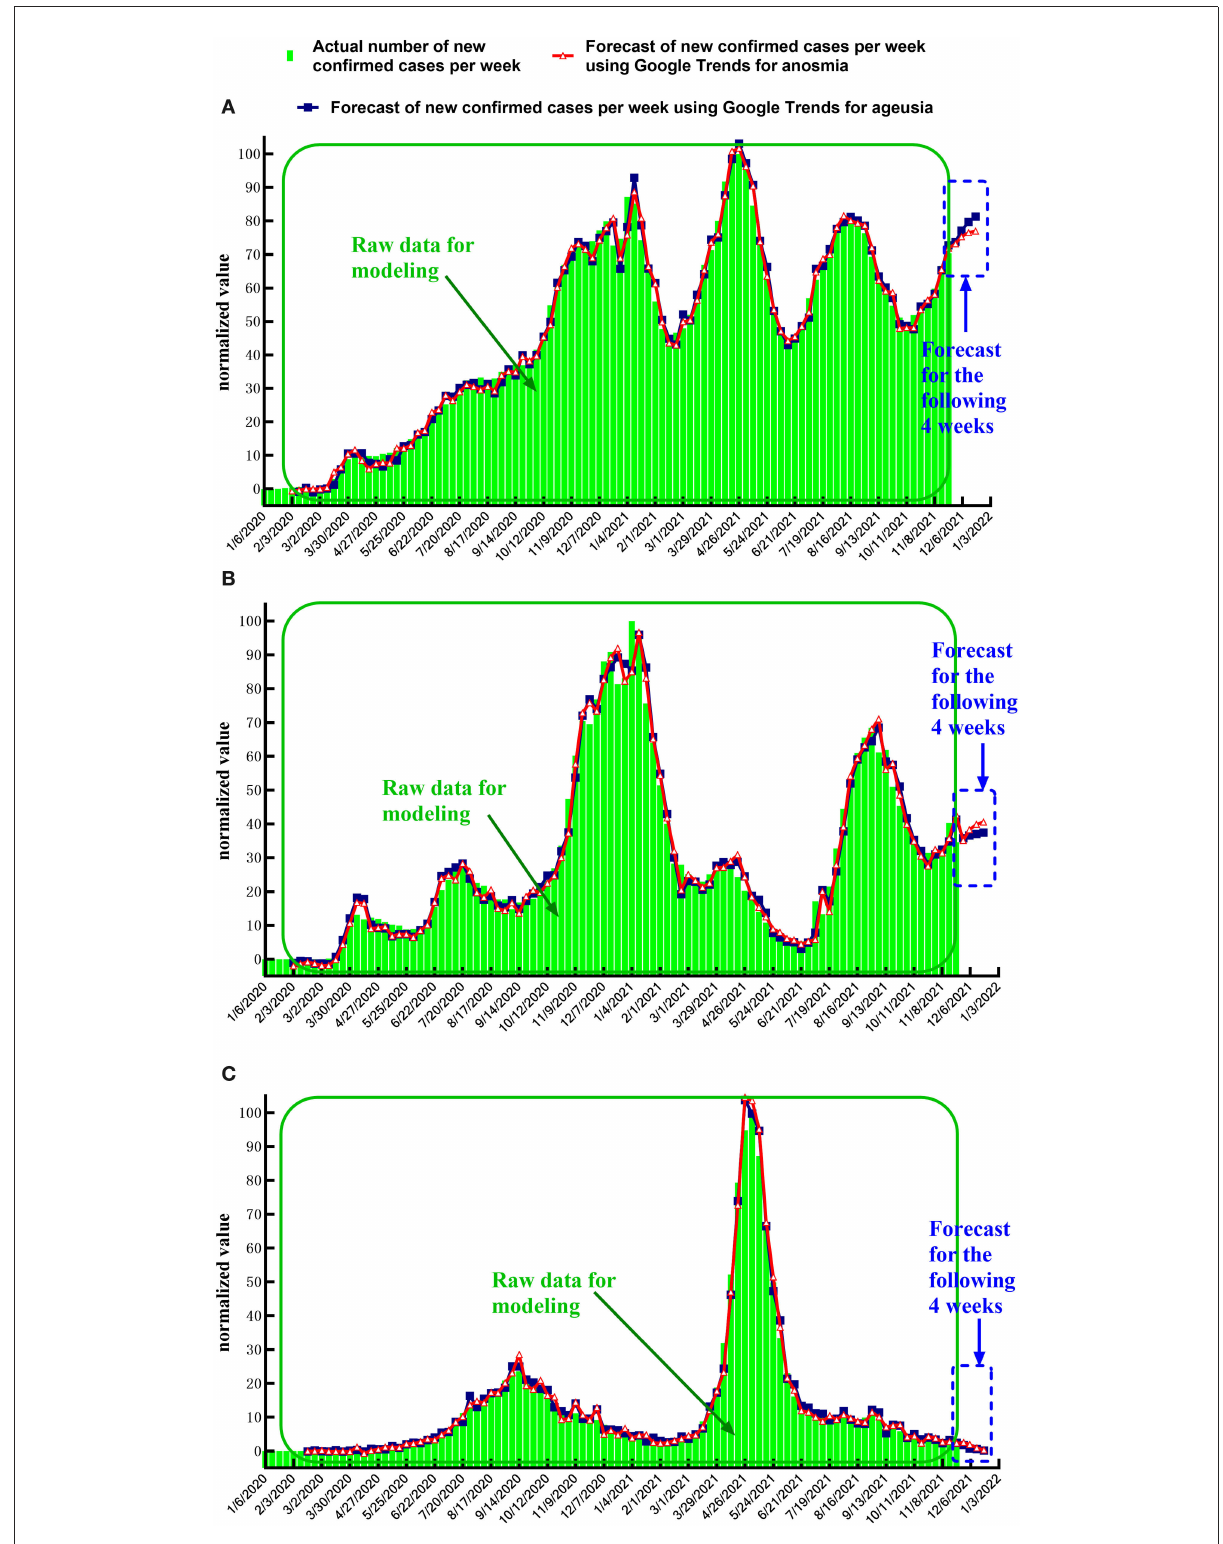
FIGURE5 Timing diagram of actual value and forecast value for weekly new cases. (A) Global, (B) United States, and (C)